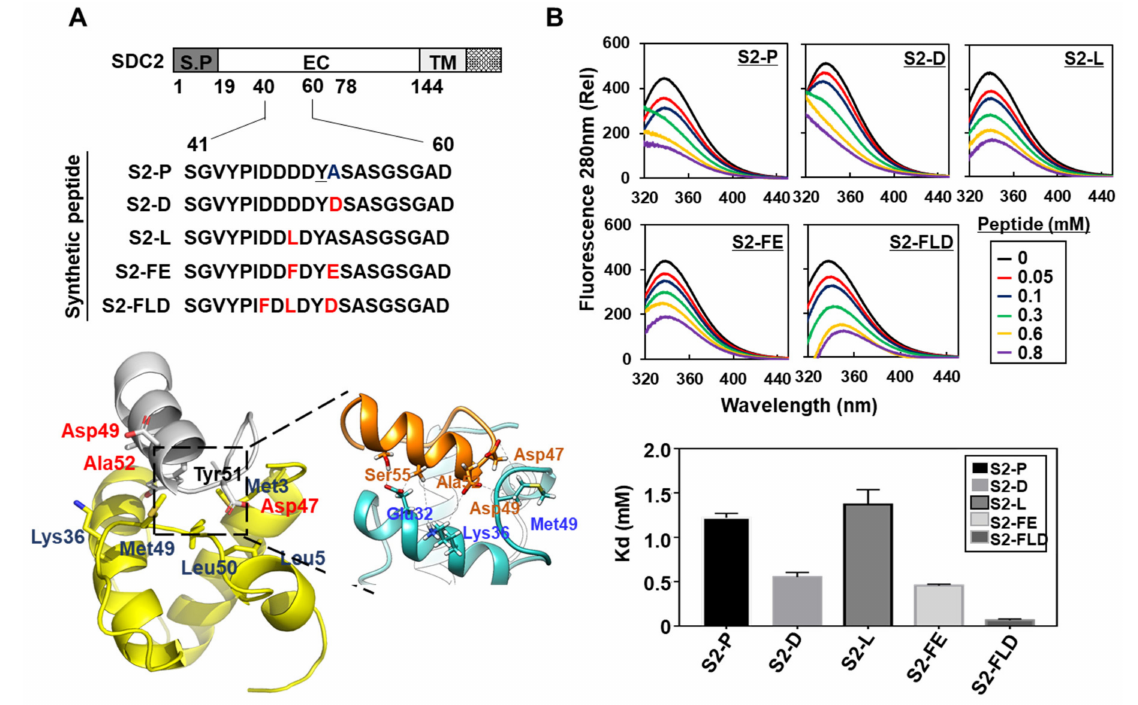
Figure 2. Synthetic peptides derived from SDC2 interacted with the MMP-7 pro-domain. ( A ) Schematic representation of the SDC2 core protein. The signal peptide (SP), the extracellu- lar domain (EC), the transmembrane domain (TM), and the cytoplasmic domain (CT) of SDC2 are noted. Amino acid sequences of the peptide corresponding to residues 41–60 of the SDC2 extra- cellular domain (S2-P) and its modified peptides (S2-D, S2-L, S2-FE, S2-FLD) are shown. Tyr 51, which is critical for the interaction, is underlined, and alteration sites of the amino acid sequence are colored red. The docking structure of S2-P and PDMMP-7 is visualized using the ribbon diagram. ( B ) Interaction of PDMMP-7 with the indicated peptides was analyzed with fluorescence spectroscopy (top). Titration between PDMMP-7 and the peptides was performed, and the Kd value was calculated